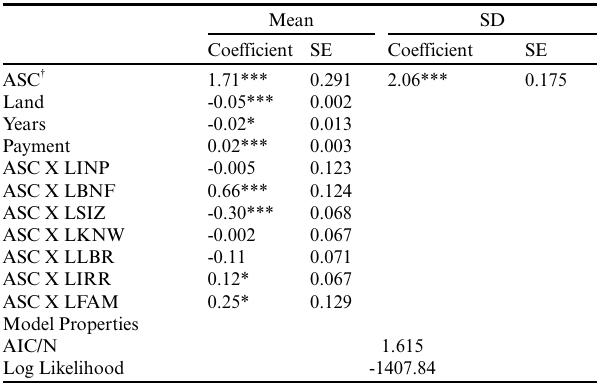
Table 5. Estimated beta coefficients for a random parameter logit (RPL) with interactions. We allowed the alternative specific constant (ASC) to be a normally distributed random variable. We also included fixed parameters in the model that interacted the ASC with the socio-psychological characteristics of respondents from choice experiment surveys conducted in the buffer area of Pench Tiger Reserve, India in 2018–2019. The sign of the coefficients indicates the correlation between landowner characteristics and their preferences. Estimates are from the best- fit model based on